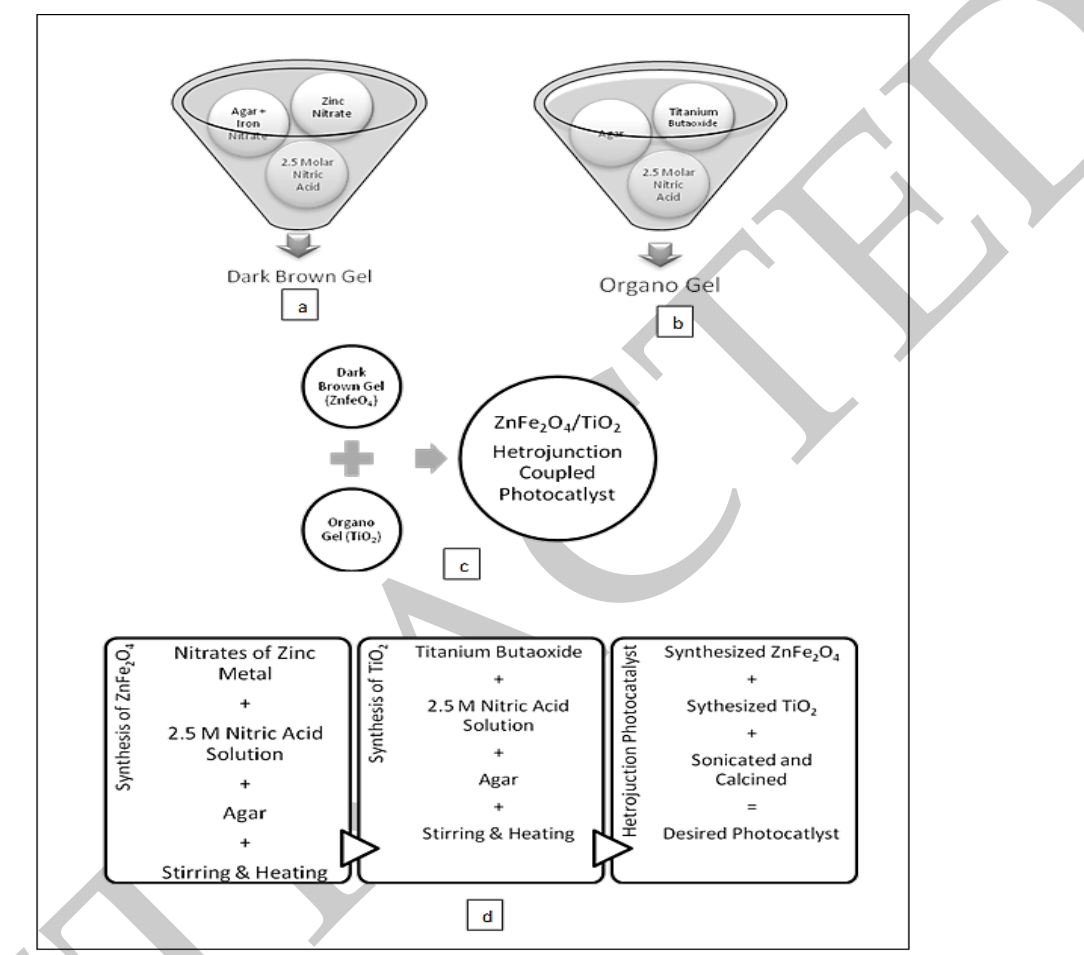
Figure 11. ( a ) Steps involved in synthesis of zinc ferrite, ( b ) steps involved in synthesis of titanium dioxide, ( c ) coupling of zinc ferrite and titanium dioxide, ( d ) detailed steps involved in synthesis of the photocatalyst.